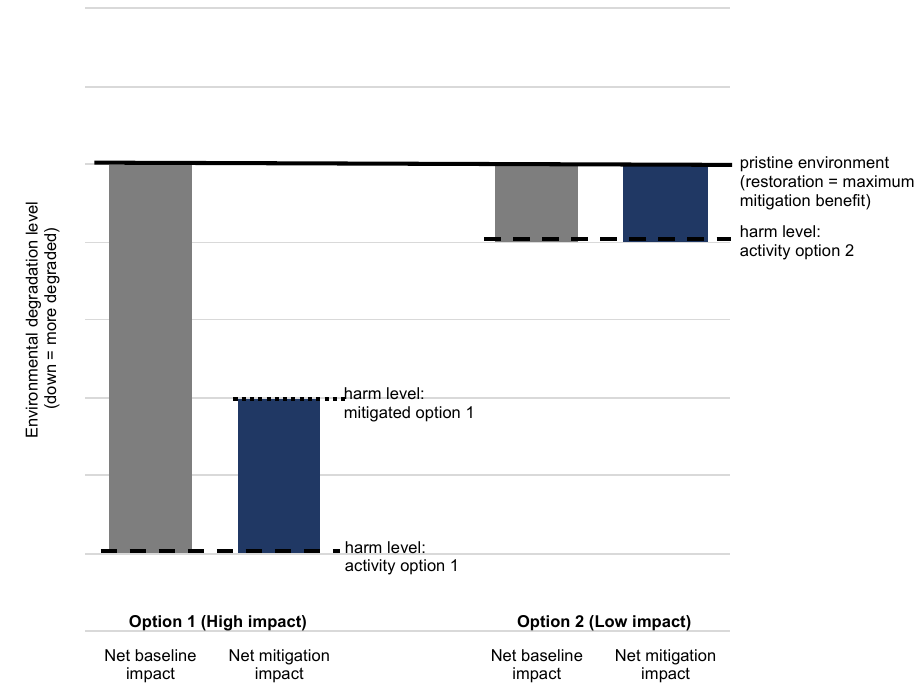
Figure 1. Mitigation infrastructure improves environmental conditions relative to a degraded baseline, not relative to a pristine environment. Life cycle assessment (LCA) typically evaluates environmental burdens imposed by some activity (dark grey). Mitigation LCA is different than typical LCA studies because there is some implied improvement to environmental conditions, but it is important to note that this improvement is relative to the degraded, not pristine, environmental baseline (dark blue) when describing environmental outcomes as “benefits.” Mitigation cannot improve conditions relative to the pristine baseline, though more of a mitigation activity could theoretically result in a restored pristine condition for the mitigation target (as shown for Option 2). Thus, the “benefit” of mitigation differs from harms traditionally assessed by LCA in that doing more of the activity does not necessarily proportionately increase it.